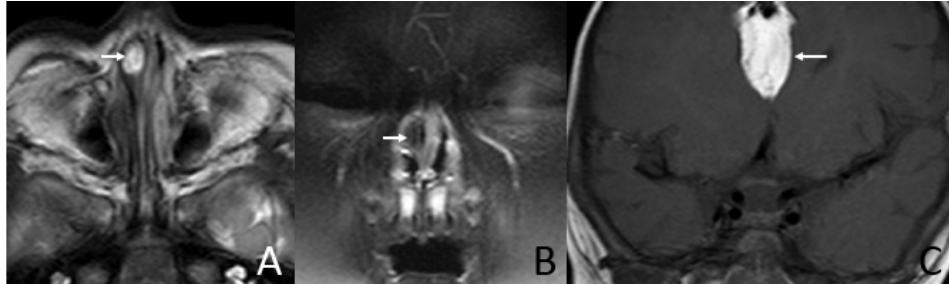
Figure 3. MRI of a 6-month-old and 18-day-old girl presenting shortly after birth with nasal obstruc- tion. ( A ) Axial T2-weighted MRI shows a sausage-like mass (arrow) in the right nasal vestibule and nasal limen that is mainly high-signal with linear low-signal inside. ( B ) Coronal T2W-SPIR MRI shows the hyperintensity component of the mass suppressed (arrow). ( C ) Coronal T1-weighted MRI shows an irregular mass (arrow) containing fat in the intracranial midline that mainly has a high-signal with irregular linear low-signal inside.